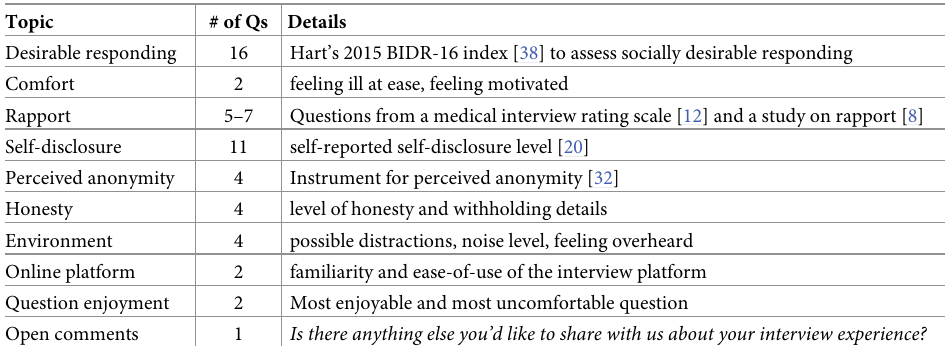
Table 2. Summary of interviewee post-interview